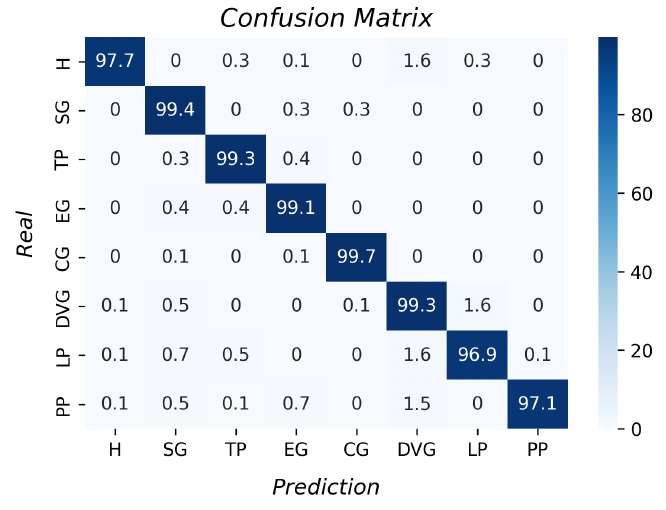
Figure 13. Accuracy per type of grasp for the k-NN algorithm.